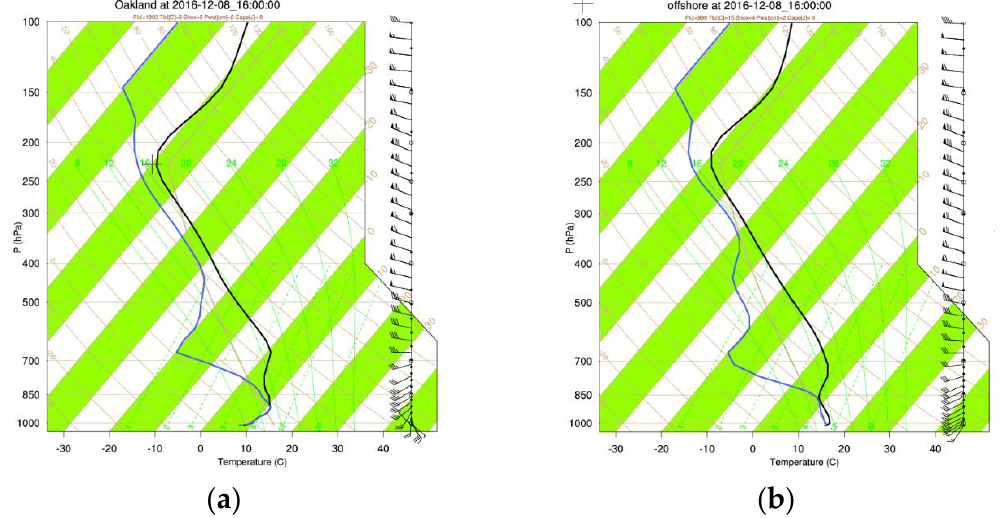
Figure 15. WRF-simulated soundings at gridpoint closest to OAK ( a ) and to the southwest of Oakland over the ocean ( b ). Both are valid at 15Z on 8 December 2016.